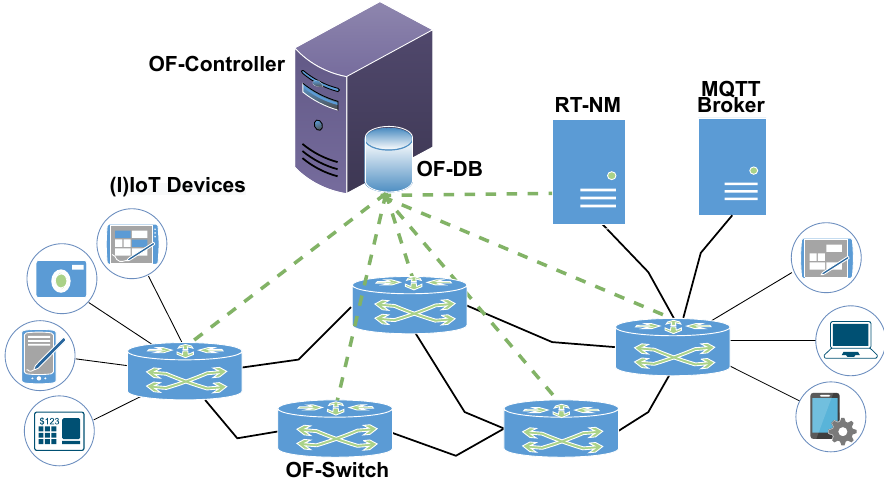
Figure 1. High-level RT-MQTT system